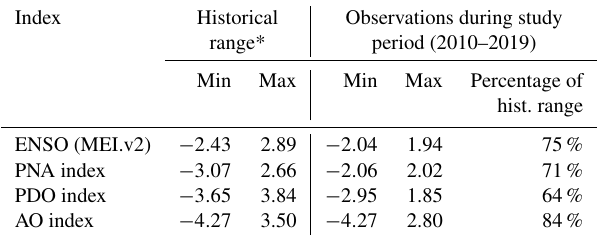
Table 2. Overview of monthly atmosphere–ocean oscillation in- dices (ENSO: El Niño–Southern Oscillation; PNA: Pacific North America Teleconnection Pattern; PDO: Pacific Decadal Oscillation; AO: Arctic Oscillation; PO: averaged Pacific-centered